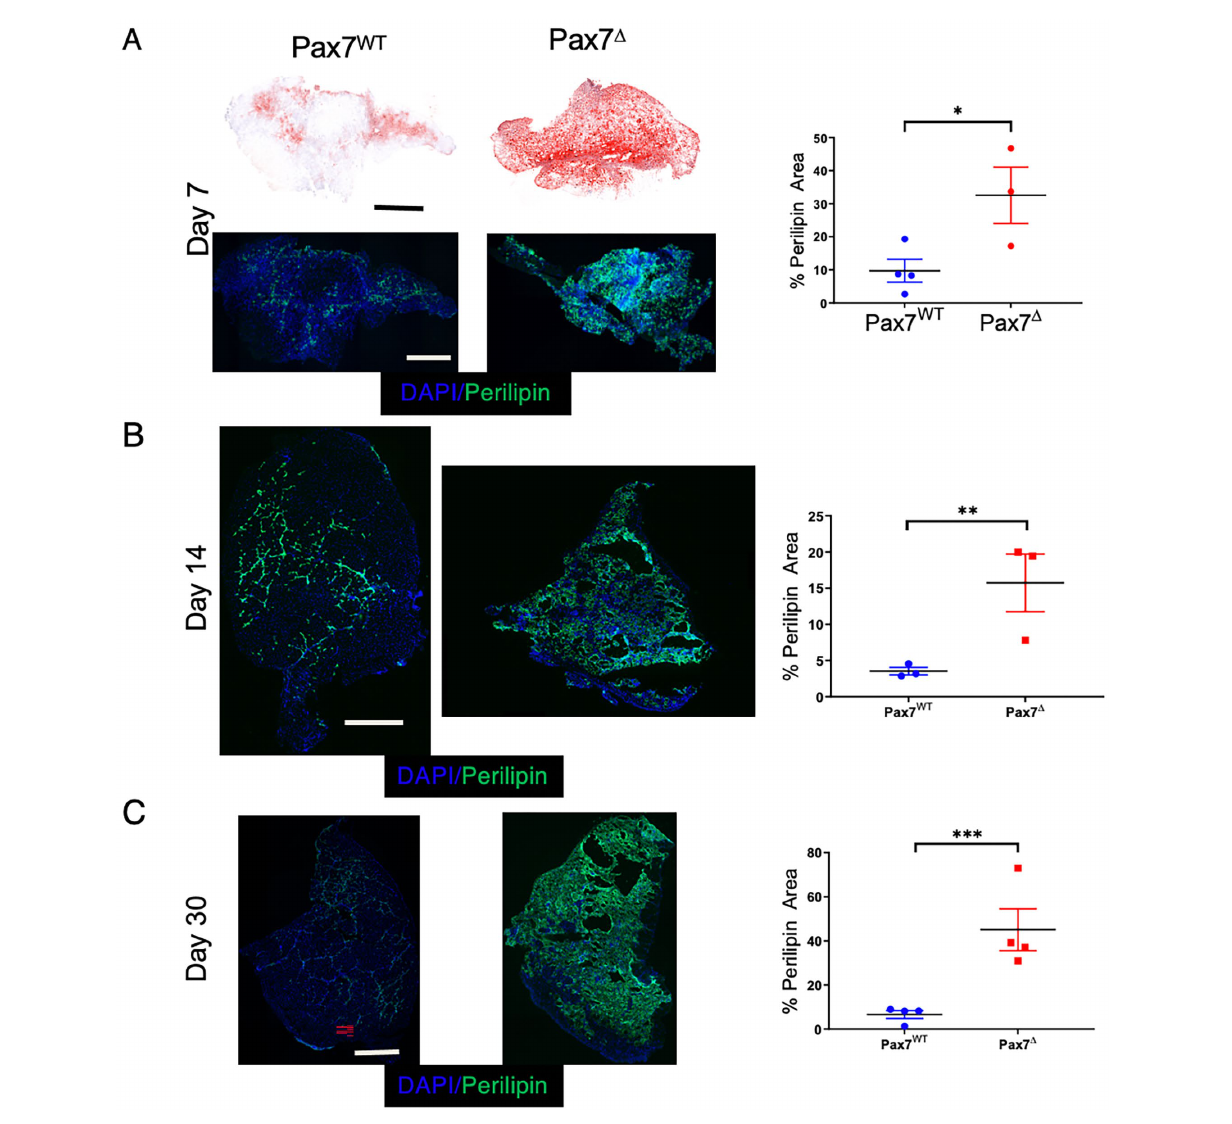
FIGURE 5 Ablation of Pax7 + MPCs in mice results in marked fat infiltration within skeletal muscle following ischemia. (A) Oil red O ( top ) and Perilipin ( bottom ) staining of the ischemic TA muscle demonstrated significantly increased lipid staining in Pax7 Δ mice compared to Pax7 WT 7 days after HLI surgery ( n = 3–4 per group). (B,C) Perilipin staining and quantification of adipose in the ischemic TA muscle 14 days (B) and 30 days (C) after HLI surgery demonstrated increased lipid staining in Pax7 Δ mice compared to Pax7 WT ( n = 3–4 per group). Scale bars = 1 mm. All data shown are means +/-SEM. * represents p < 0.05, ** p < 0.01; *** p < 0.001 by 2-sided t